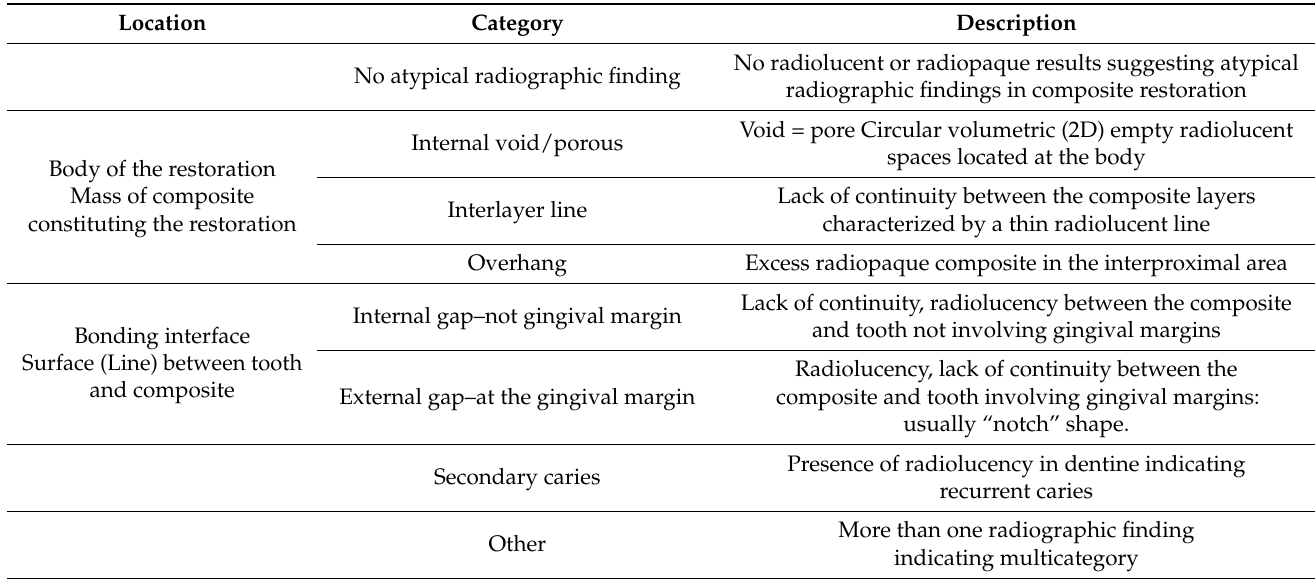
Table 1. Description of the categories for classification of